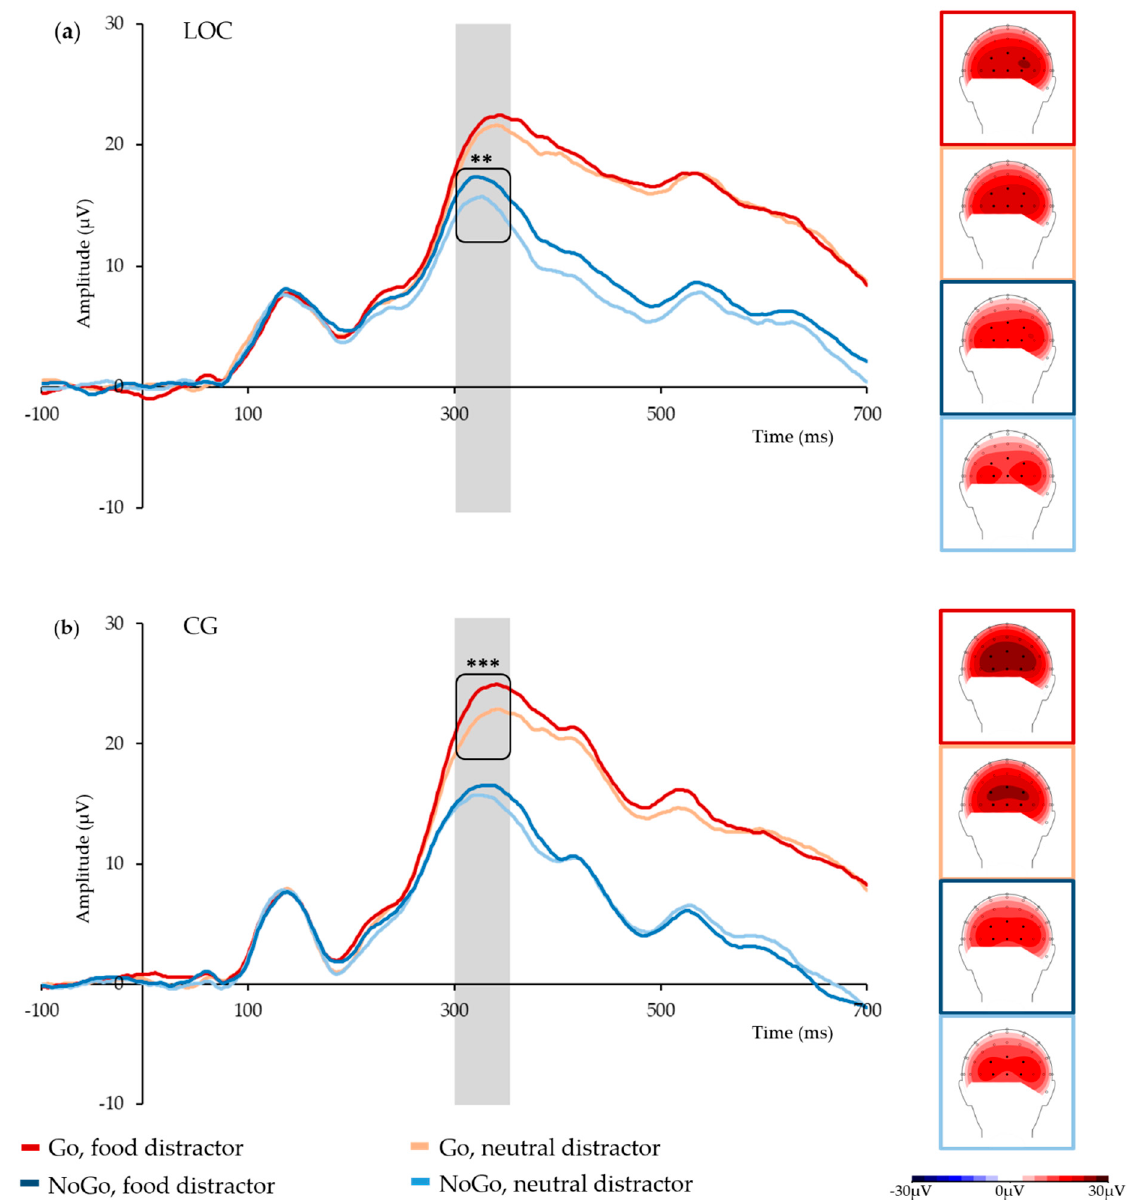
Figure 2. Grand average P300 time courses in the analyzed electrode cluster, and topographies by condition and group: ( a ) group with loss of control eating (LOC); ( b ) control group (CG). The P300 time window is marked in grey; black dots mark the analyzed electrodes; ** marks p < 0.01, *** marks p < 0.001. Table 2. Mean EEG amplitudes for the group with loss of control eating (LOC) and the matched control group (CG).